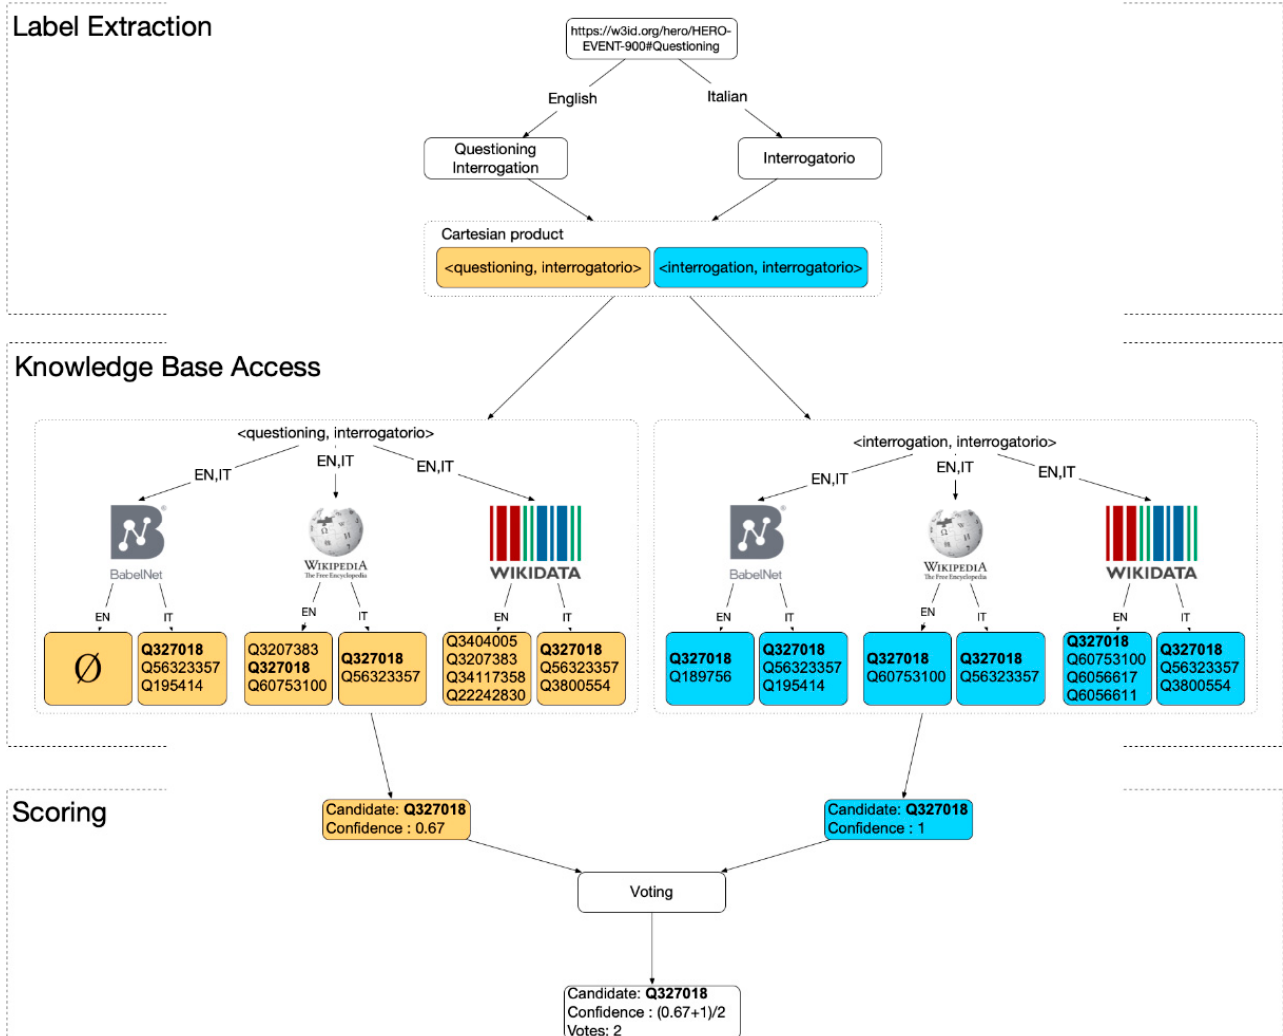
Figure 5. Picture representing the automatic matching strategy. The three steps, namely Label Extraction, Knowledge Base Access, and Scoring are depicted by starting from the HERO Questioning label.